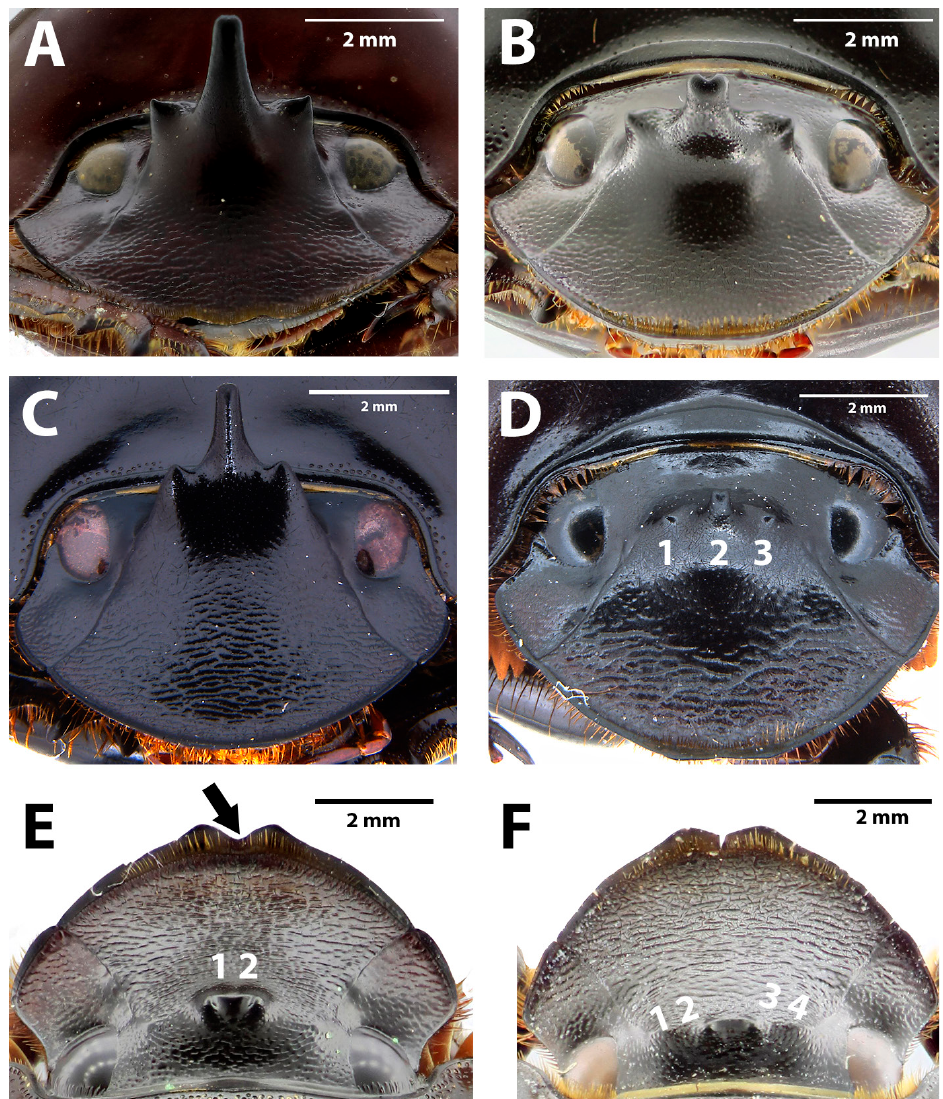
Fig. 1. Diagnostic characters of the Dichotomius ( Luederwaldtinia ) agenor species group. A–D . Male diverse trituberculate fronto-clypeal carina shapes. A . D. tristis (Luederwaldt, 1923). B . D. amplicollis (Harold, 1869). C . D. belus (Harold, 1880). D . D. validipilosus (Luederwaldt, 1931) . E–F . Female fronto-clypeal carina. E . Bituberculate carina typical of D. tristis . F . Quadrituberculate carina typical of D. amplicollis